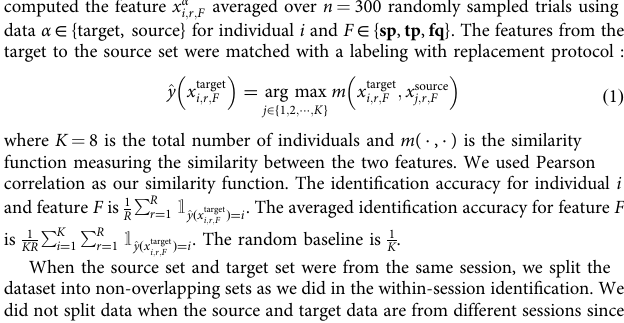
Figure 1 of Ref. 48: Left Frontal (LF), Right Frontal (RF), Left Temporal (LT), Right Temporal (RT), Left Parietal (LP), Right Parietal (RP), Left Occipital (LO), Right Occipital (LO). Each subfeature was the rows and columns of the spatial correlation matrix corresponding to the sensors in one of the eight groups: let Σ 2 R 102 ´ 102 be the spatial correlation matrix, then the subfeature corresponding s to the correlation between RT and LT, for example, is Σ s (ind RT ,ind LT ) where ind RT is the set of channel indices in the RT group and ind LT corresponds to the LT